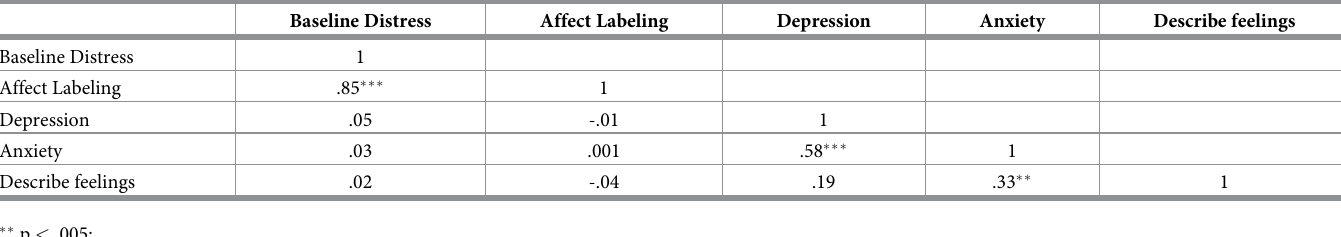
Table 2. Zero-order correlations between levels of distress in the different experimental conditions (baseline and affect-labeling), depression, anxiety, and difficulty in describing feelings.